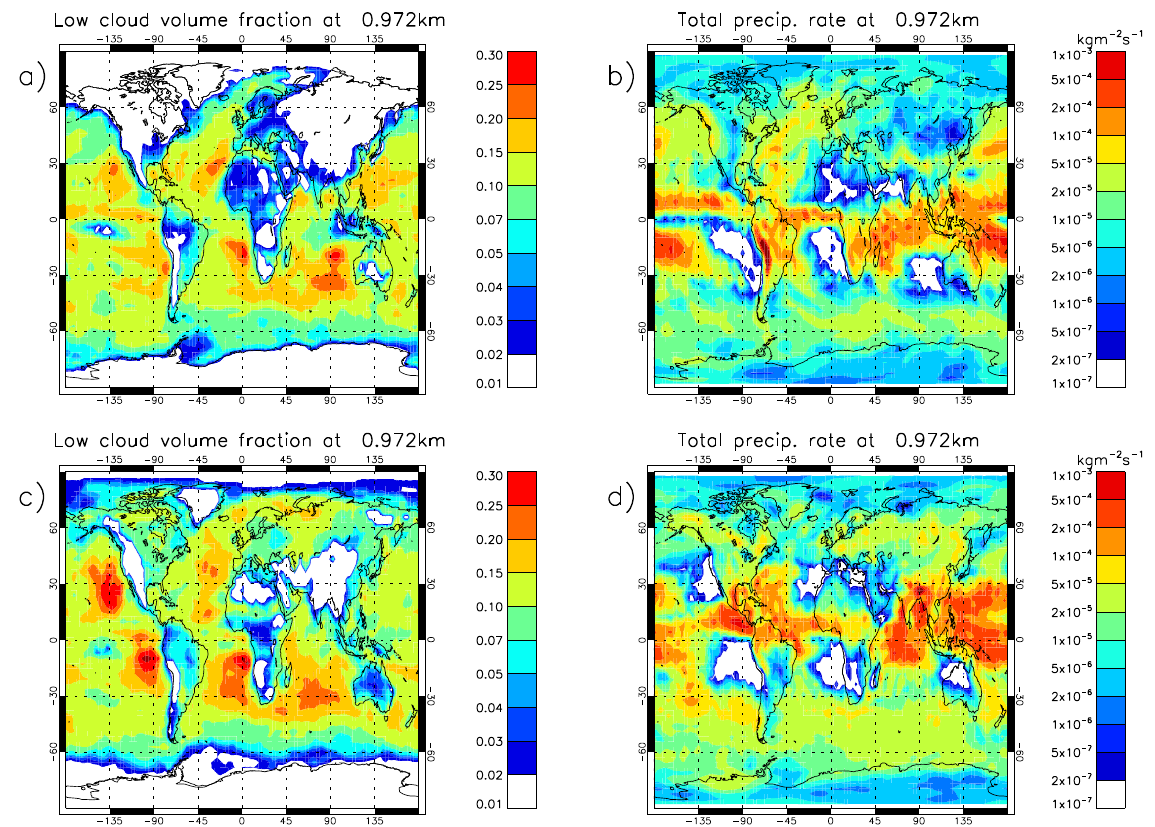
Fig. 2. Global low-level cloud volume fraction based on ISCCP global D2 all-cloud data (left column) and total (large-scale and convective- scale) modelled precipitation rate at ∼ 879hPa (right column) for January (top row) and July (bottom